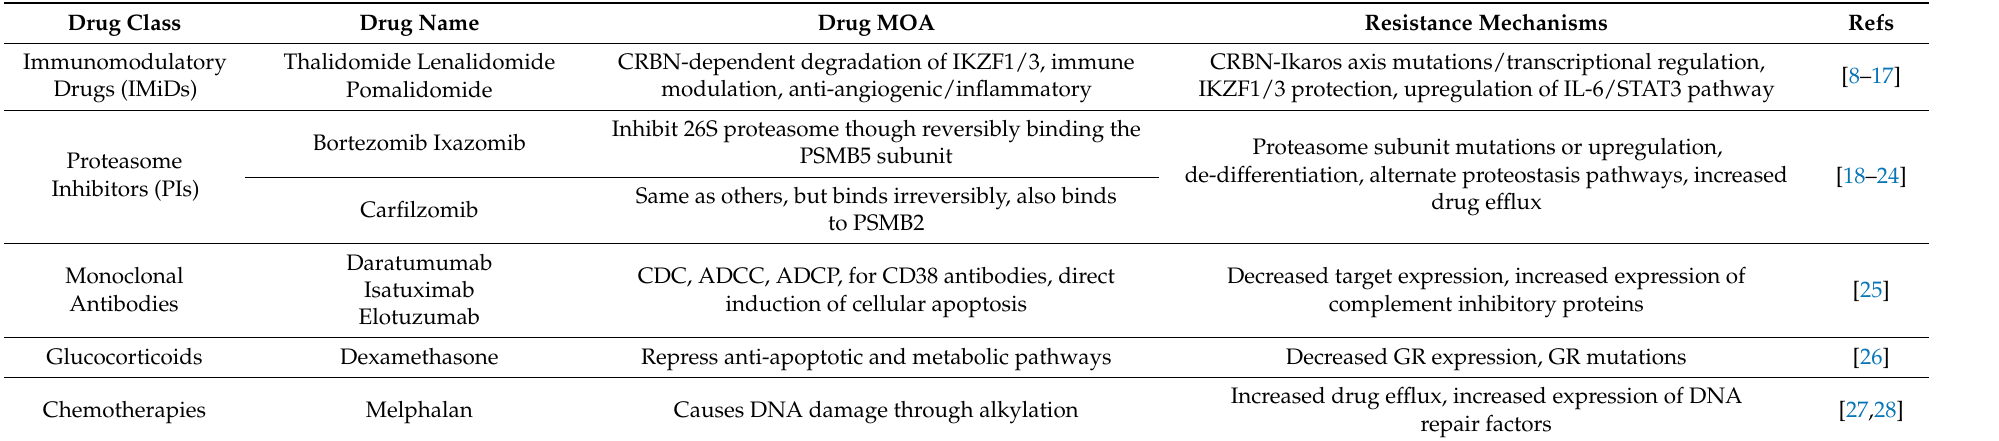
Table 1. Resistance mechanisms to targeted therapies in multiple